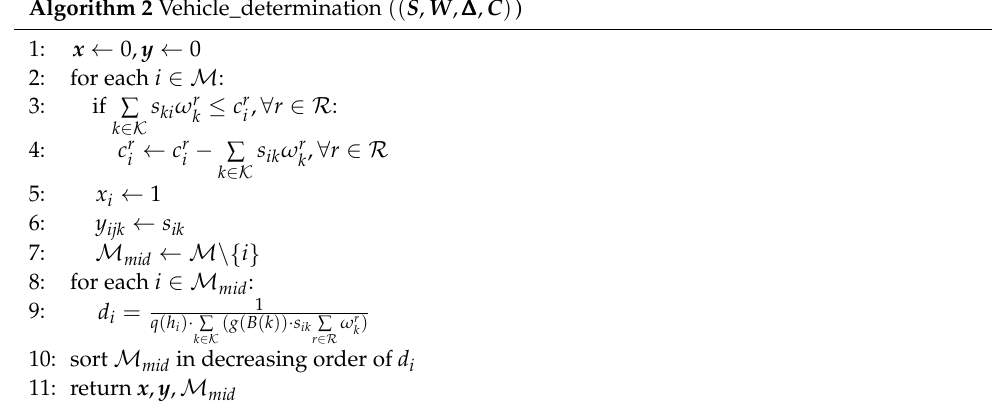
Algorithm 2 Vehicle_determination (( S , W , ∆∆∆ , C )